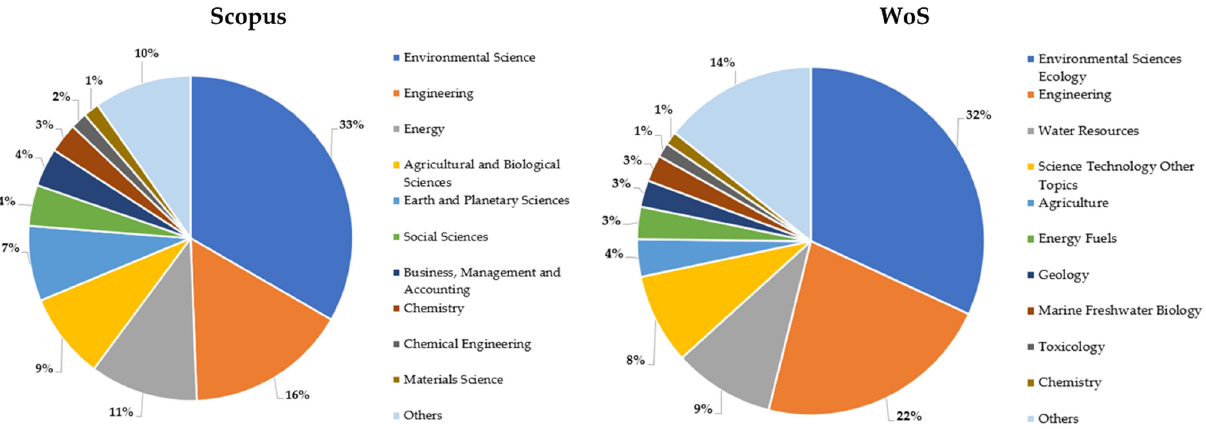
Figure 6. Main subject areas of the scientific field in Scopus and Web of Science (WoS). Documents: 622 Scopus and 474 WoS.